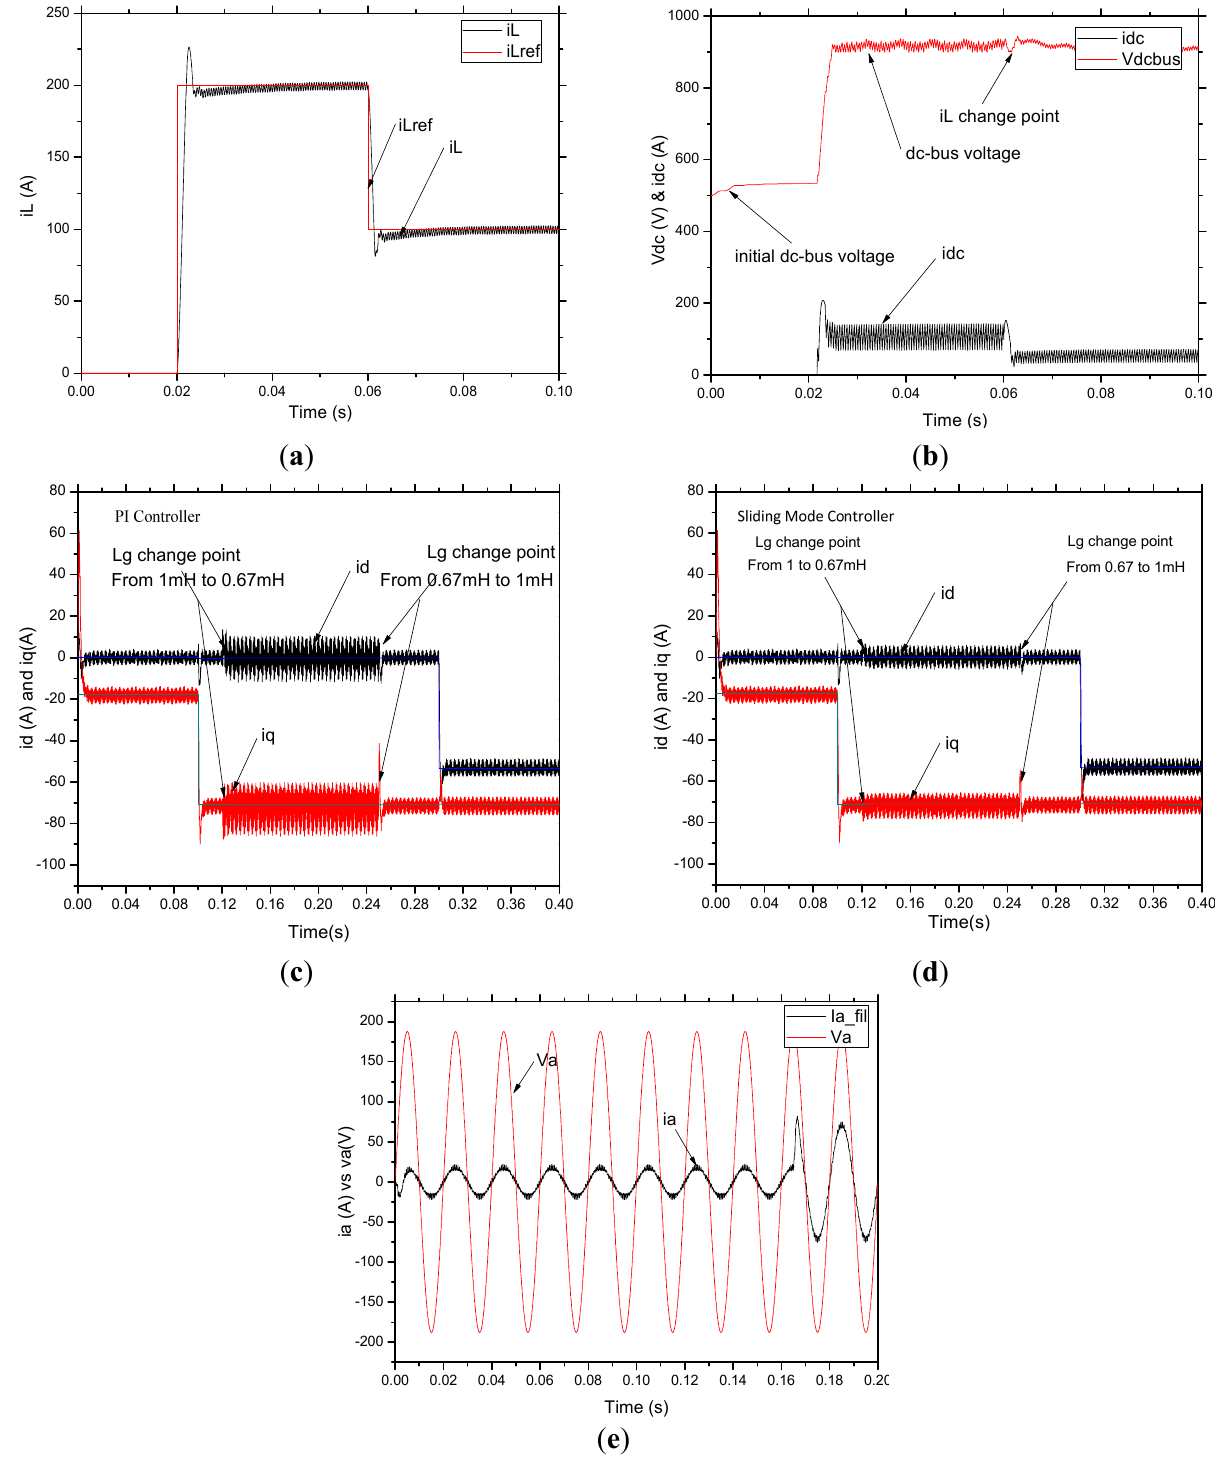
); Figure 9. ( a ) Experimental results of time response vs. discharging current ( i L ( b ) Experimental results of time response vs. dc-bus voltage ( V ); ( c ) Experimental dcbus and i ) when the grid connected results of active and reactive current components ( i d q interface inductor changes by using the PI method; ( d ) Experimental results of active and and i ) when the grid-connected interface inductor changes reactive current components ( i d q from 0.67 mH to 1 mH by using SMC method; ( e ) Experimental results for grid-connected ) and grid voltage of the system ( v current ( i a an